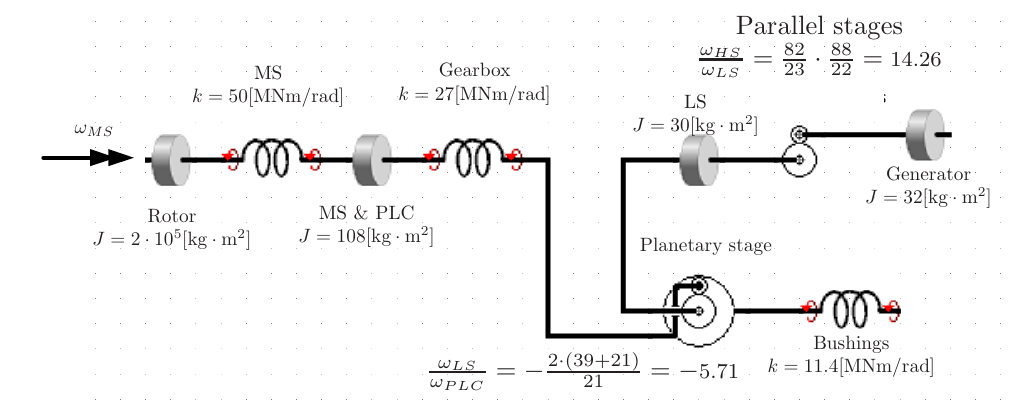
Figure 12: Diagram of SimulationX model of the gearbox. Inertia, stiffnesses and gear ratios are added ings are included or not yielding, 1 . 47[rad/s]